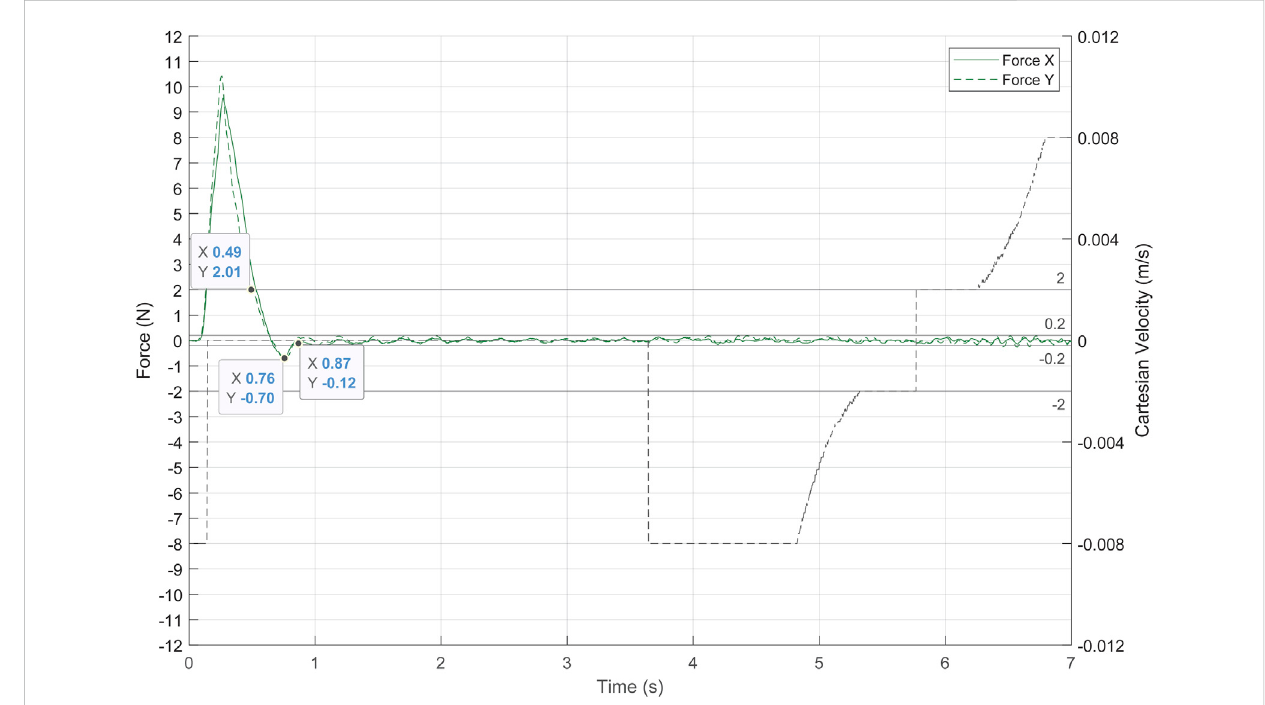
FIGURE 13 Systemresponsetoanaccident,simulatedbyafastmovementofthepelvitrainer.ThedashedblacklinerepresentstheTCPCartesianspeed,andthe green lines represent the contact